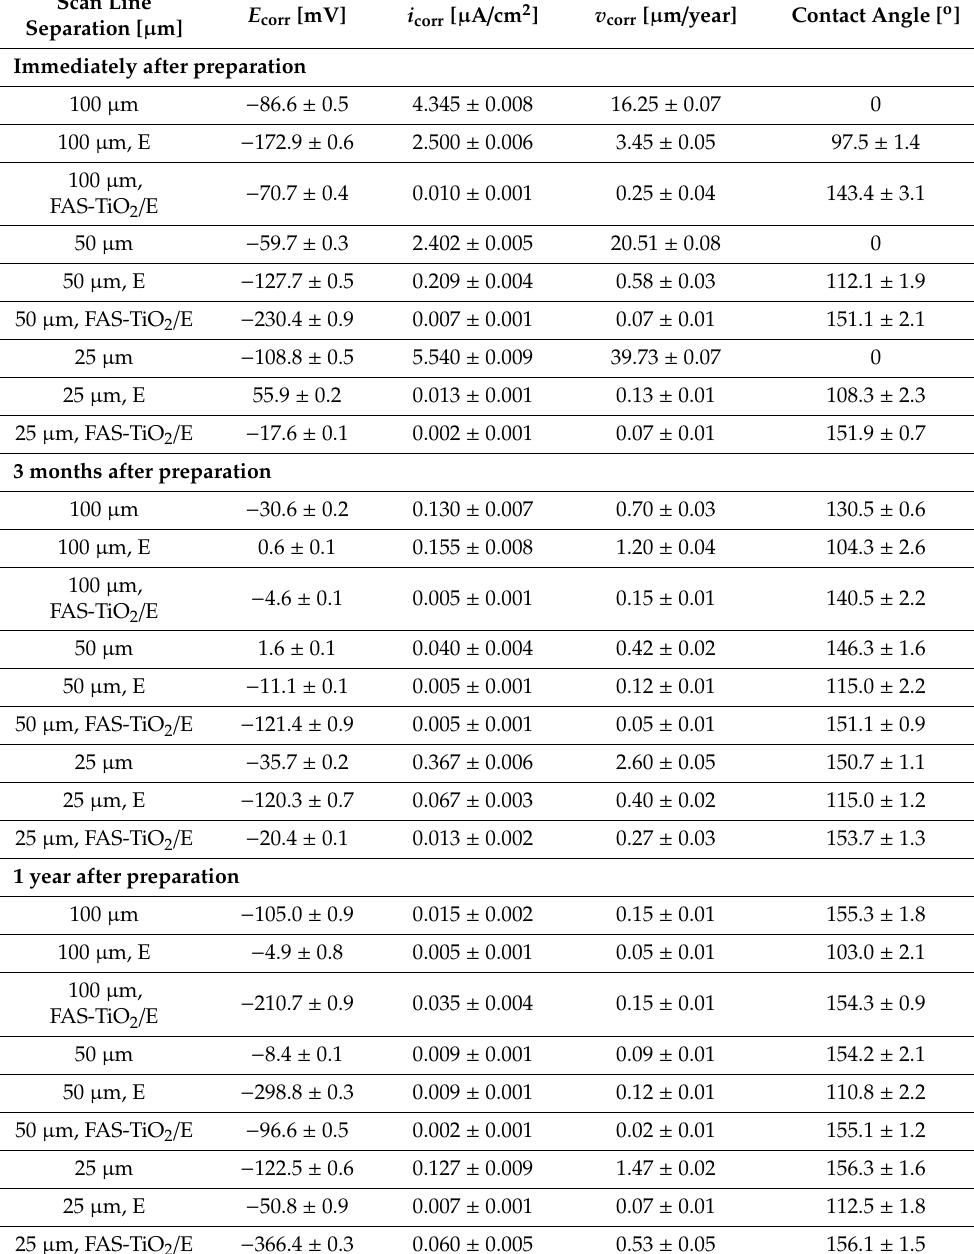
Table 4. Corrosion characteristics of uncoated, epoxy-coated and FAS-TiO 2 / epoxy-coated laser-textured steel surfaces with di ff erent scan line separations ( ∆ x = ∆ y = 100, 50, 25 µ m) calculated from the electrochemical measurements in a simulated physiological Hank´s solution and corresponding static water contact angles immediately after laser-texturing, after 3 months, and 1 year, when stored in ambient